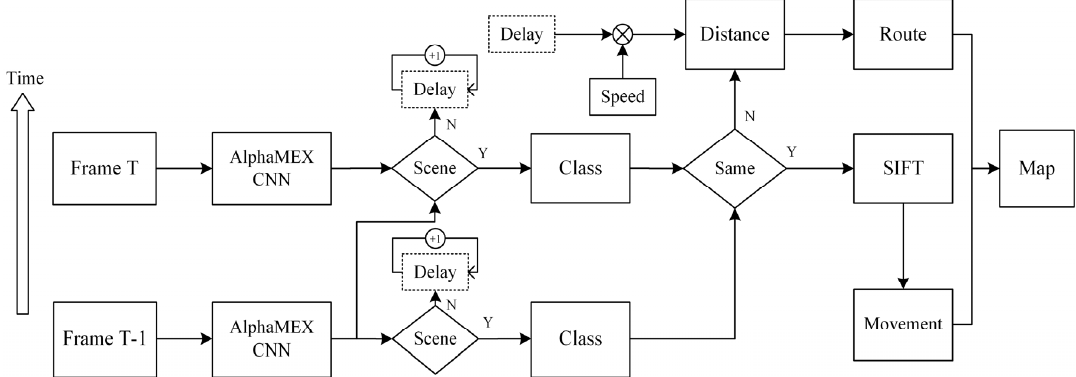
Figure 9. The iterative structure of the CNN-SIFT hybrid pedestrian navigation. The blocks with a dotted line indicate the global parameter. Each frame will be firstly analyzed by AlphaMEX CNN for the scene classification, then compared with the previous frame to decide whether to run the SIFT-based movement calculation. Routes will be calculated by the global parameter Delay and the walking speed if the scene changed. Movements and routes will be plotted on the map for pedestrian navigation.